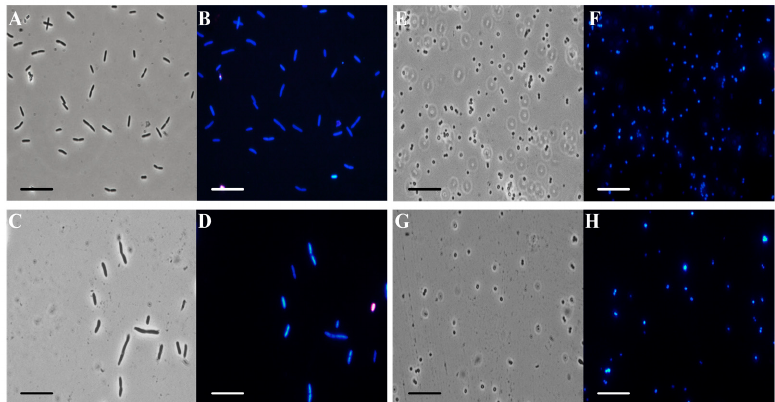
Figure 3. Analysis by fluorescence microscopy. Panels show E. coli bacterial cells ( A – D ) and S. aureus bacterial cells ( E – H ). Panels ( A , C , E , G ) show the cells observed under the optical microscope, and panels ( B , D , F , H ) show the cells observed under the fluorescence microscope. Untreated bacterial cells ( A , B , E , F ); cells treated with C. aurantium ‘Crispifolia’ EO ( C , D , G , H ). Scale bars: 1 µm ( A – H ).